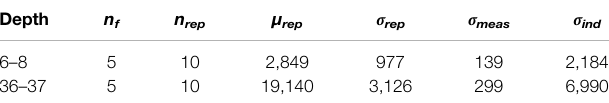
TABLE 3 | Replicated 14 C measurements on small-n samples from sub-core 1. The number of measured specimens n f as well as the number of